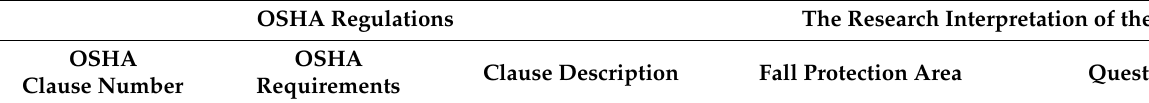
Table 2. Examples of standard clauses from Occupational Safety and Health Administration (OSHA) [12] and interpreta- tion process.